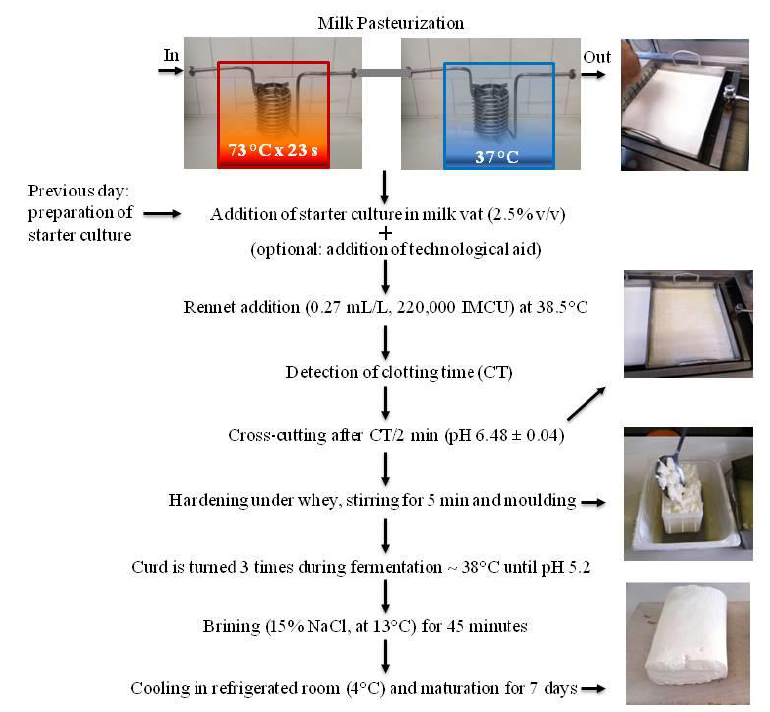
Figure 2. Flowchart of the lab-cheesemaking process set up for this study to produce Crescenza-type Figure 2. cheeses.